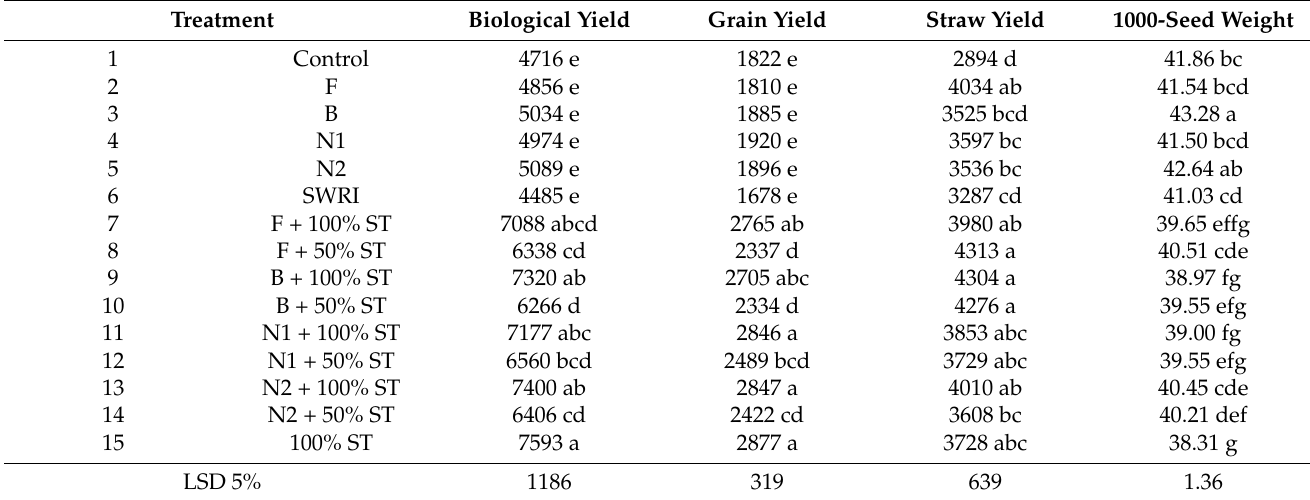
Table 2. Means comparison analysis of the effect of applied PGPR and their combinations with soil test need-based N, P, and Zn chemical fertilizers on the yield components of the Azar-2 rainfed wheat cultivar.